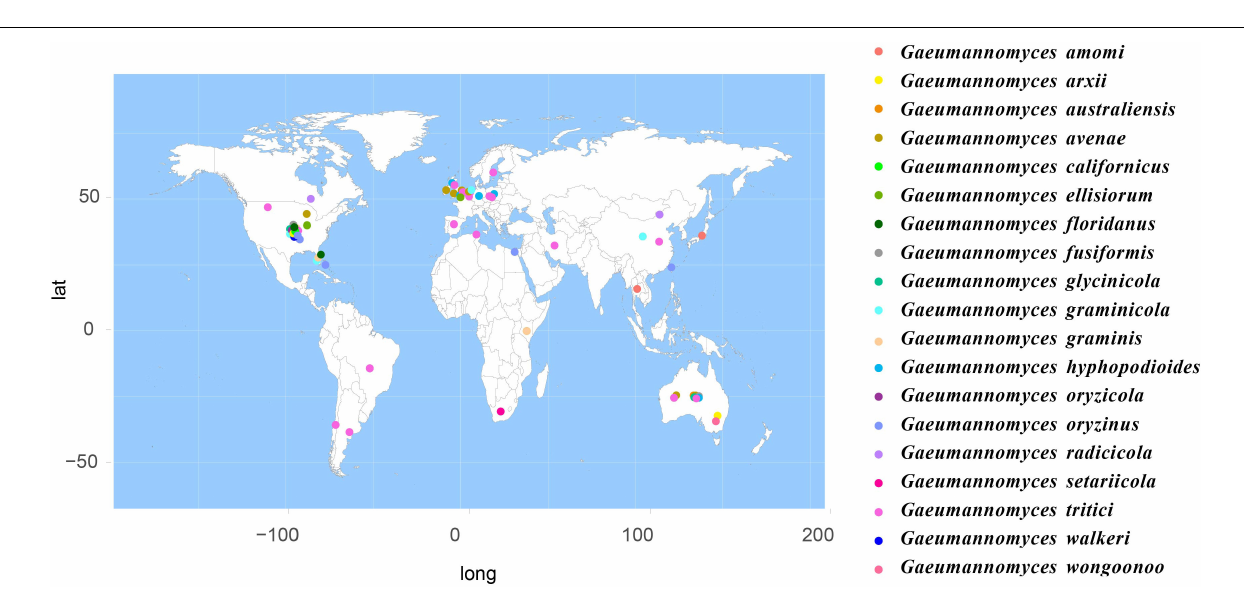
FIGURE 6 | Geographical distribution of Magnaporthales genera using meta-analysis.